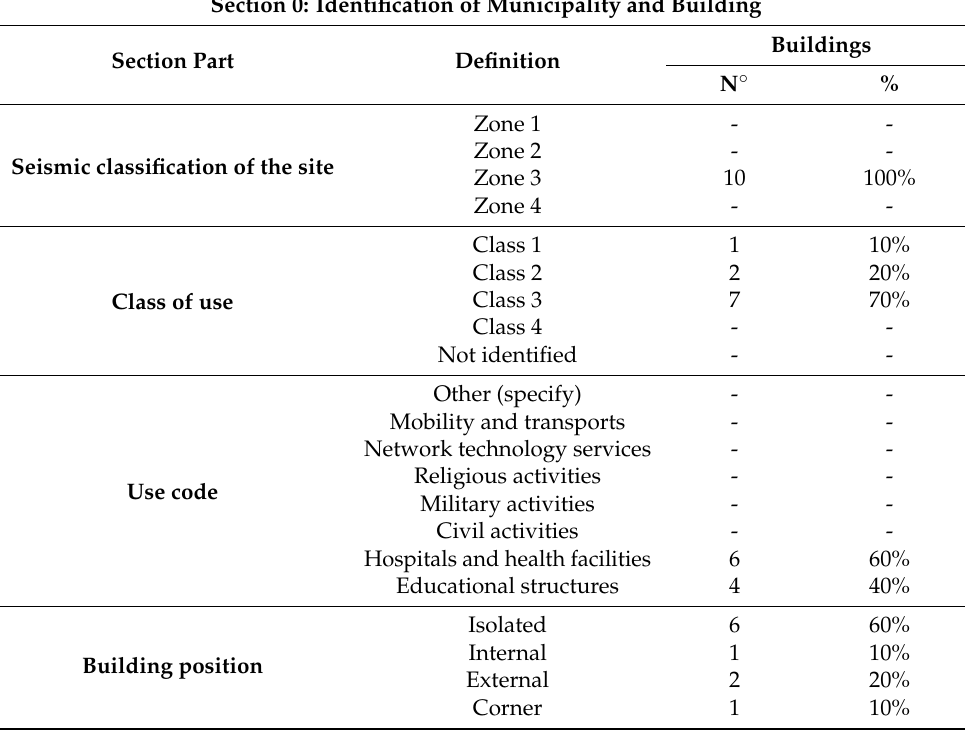
Table 2. Section 0 CARTIS-Building. Case studies characterization: Identification of municipality and building—Synoptic panel.